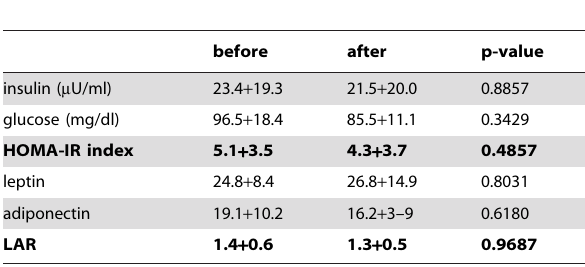
Table 2. Insulin resistance before and after belimumab